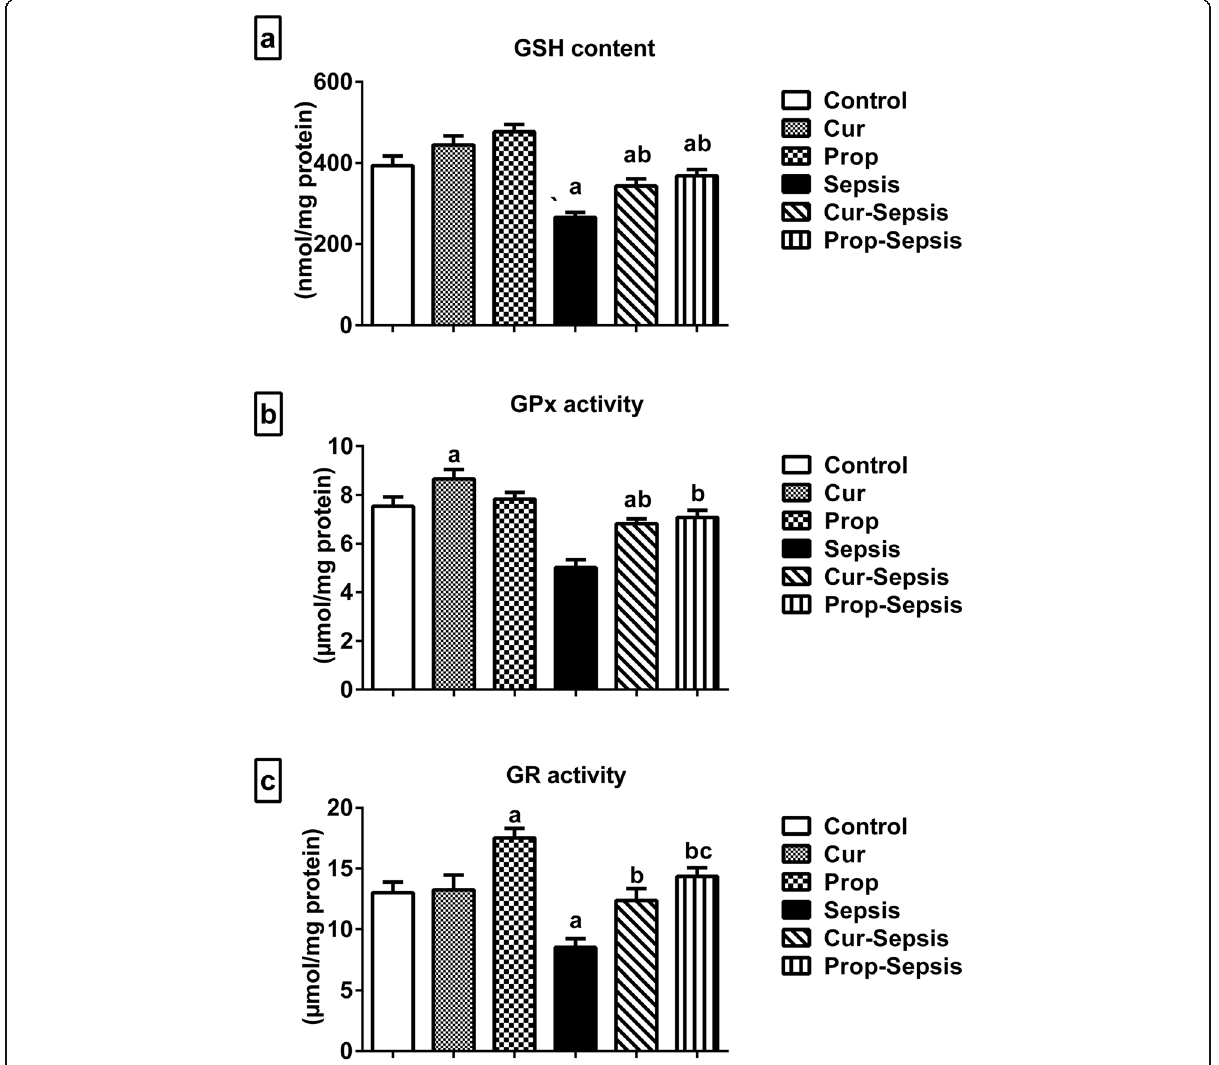
Fig. 1 The effect of either propolis (Prop) or curcumin (Cur) on a glutathione (GSH) content, b glutathione peroxidase (GPx), and c glutathione reductdase (GR) in kidney tissue homogenate after sepsis-induction in adult male rats. Data are expressed as mean ± S.E.M for 6 rats/group. a, significant difference from control group by one-way ANOVA at P < 0.05; b significant difference from SEP group by one-way ANOVA at P < 0.05; c significant difference between cur and prop-sepsis and cur-sepsis groups by one-way ANOVA at P <